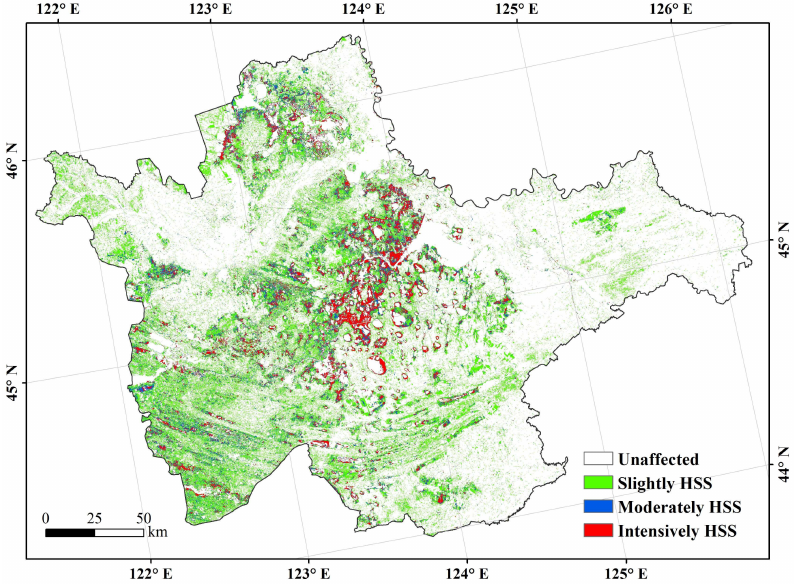
Figure 4. Distributions of hybridized salinity and sodicity (HSS) in the west